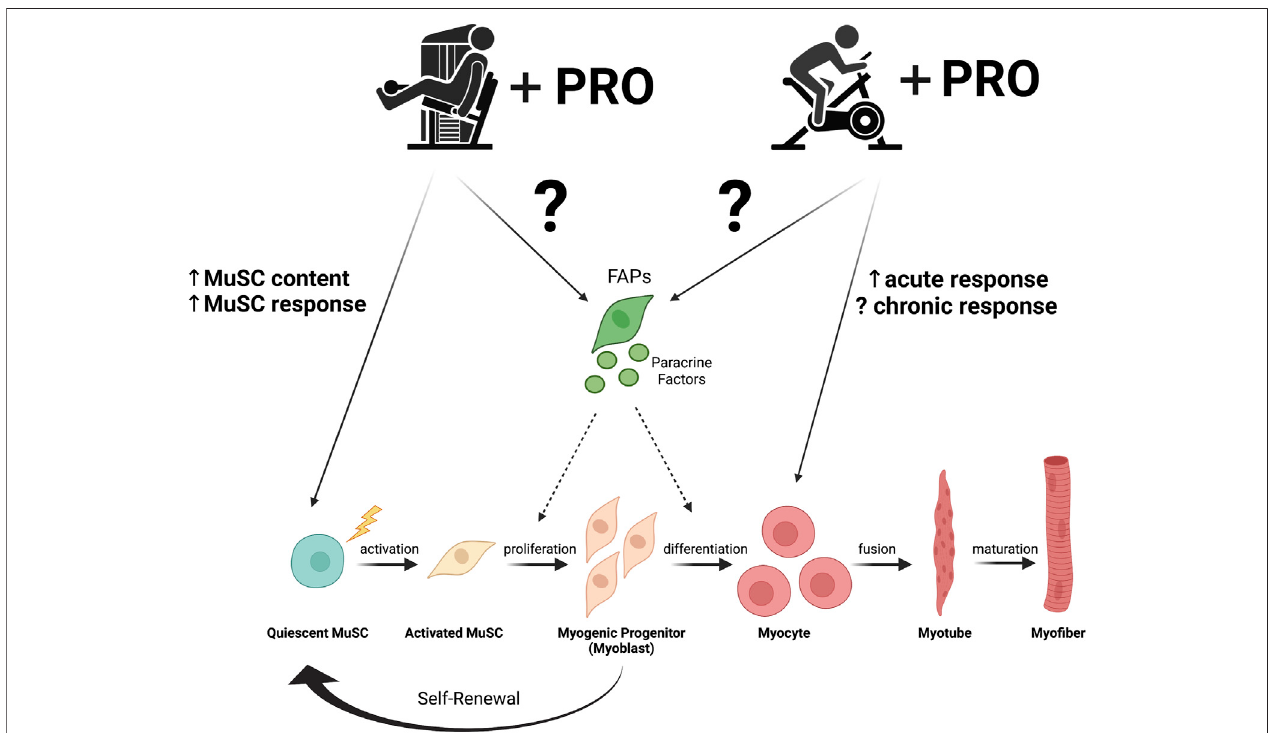
FIGURE 1 | The effects of resistance and endurance exercise plus protein consumption (PRO) on muscle stem cells (MuSC) and fi bro-adipogenic progenitors (FAPs). In response toskeletal muscle damage and signals from cells in their niche including FAPs, MuSCs exit from quiescence, proliferate, and differentiate tofacilitate musclerepair andadaptation.Generally, fi ndingsofbothacuteandchronicresistance exercisesuggest thatproteinintakeaugments theMuSC response inboth young andolderadults.Enduranceexercisehoweverislessunderstood.Acuteexercisecombinedwithproteinconsumptionappearstoupregulatemyogenictranscripts with no effects found in chronic endurance exercise. The effects of exercise, both resistance and endurance, with protein consumption on FAP function is poorly understood and requires further investigation. Figure created with BioRender.com.